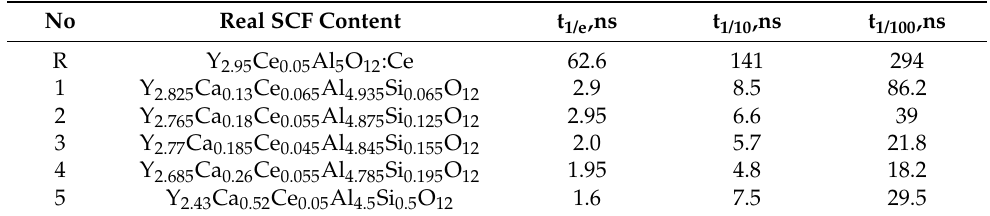
Table 2. Decay times of PL at RT in Y 3 − x Ca x Al 5 − y Si y O 12 :Ce SCFs with different Ca and Si content under excitation at 340 nm and registration of PL at 530